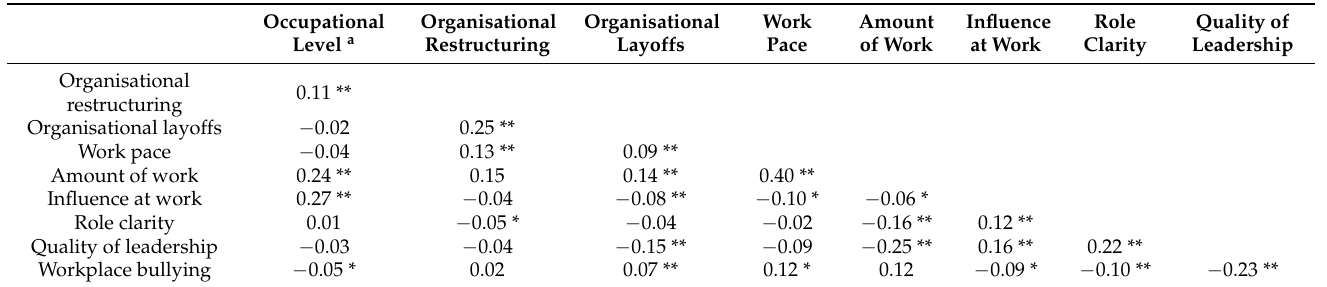
Table A2. Person r inter-correlations between variables at baseline ( N =